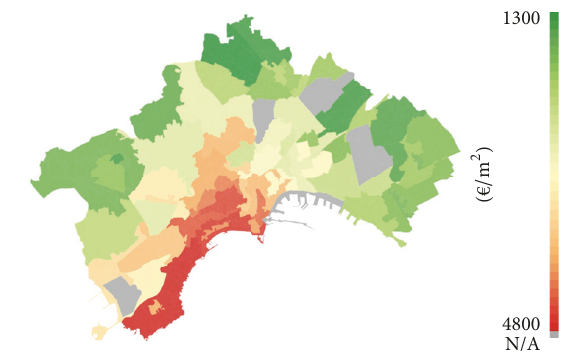
Figure 1: Census zones [44].